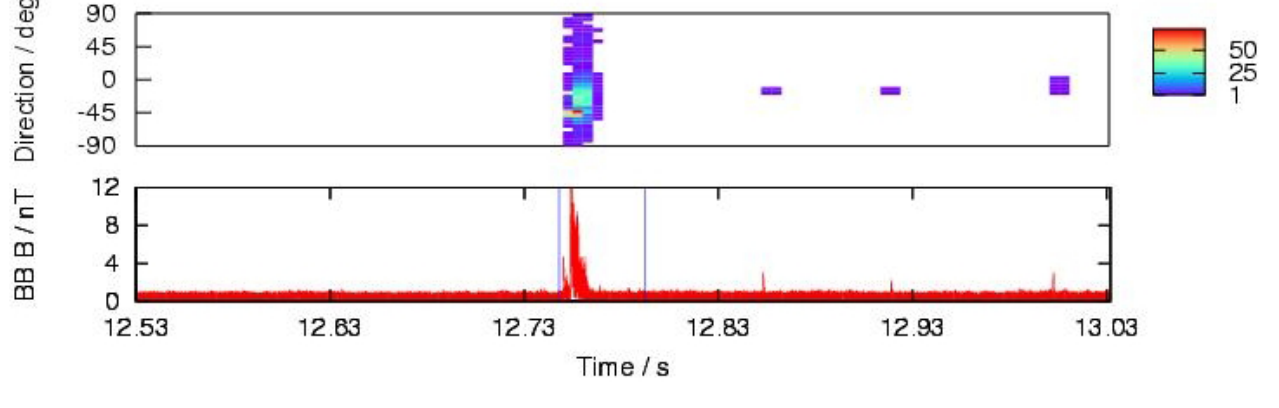
Fig. 2. The lower panel shows the combined signal intensity of the broadband EW and NS VLF recordings made at Nanc¸ay ± 250ms around the elve occurring on 24 July 2003 at 00:29:12 . 757UTC. The blue vertical lines mark the occurrence of the elve accounting for the 20ms frame integration time and a timing uncertainty of ± 12ms. The top panel shows the direction of arrival of the sferic signal at about ∼− 45 ◦ measured from the